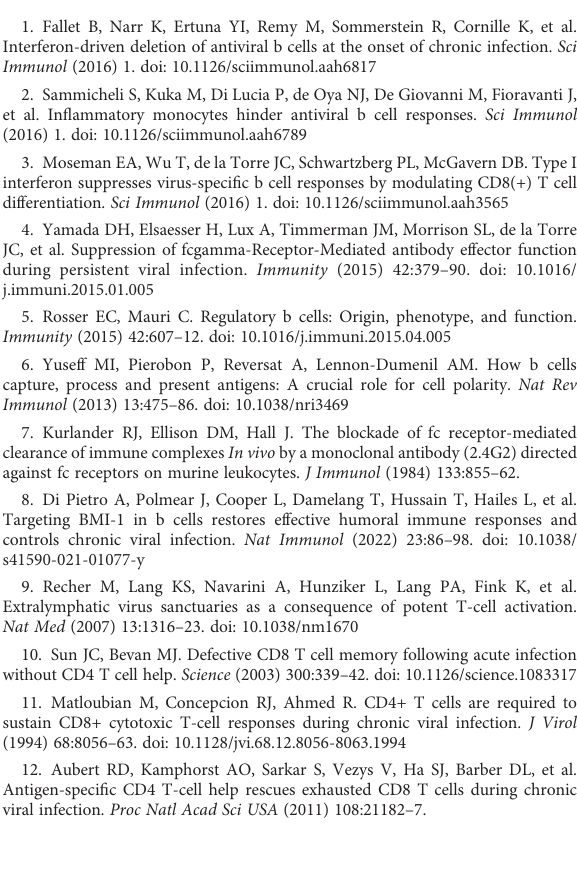
SUPPLEMENTARY FIGURE 3 Adoptive B cell therapy also improves viral control in a model of protracted infection caused by acute IFN-I blockade. (A) Experimental outline for evaluating the effect of B cell transfer during a protracted viral infection caused by IFN-I blockade. Mice received 500 m g of anti- IFNAR1 antibody (MAR1-5A3) 6 hours prior to LCMV Cl-13 WE-GP infection. Mice received 5x10 6 KL25H B cells after 2 weeks post- infection. (B) Summary of viral control in sera. Data are from one representative experiment with, n=4-5 mice per experiment. Error bars represent SEM. The p-values were calculated using Mann- Whitney test.